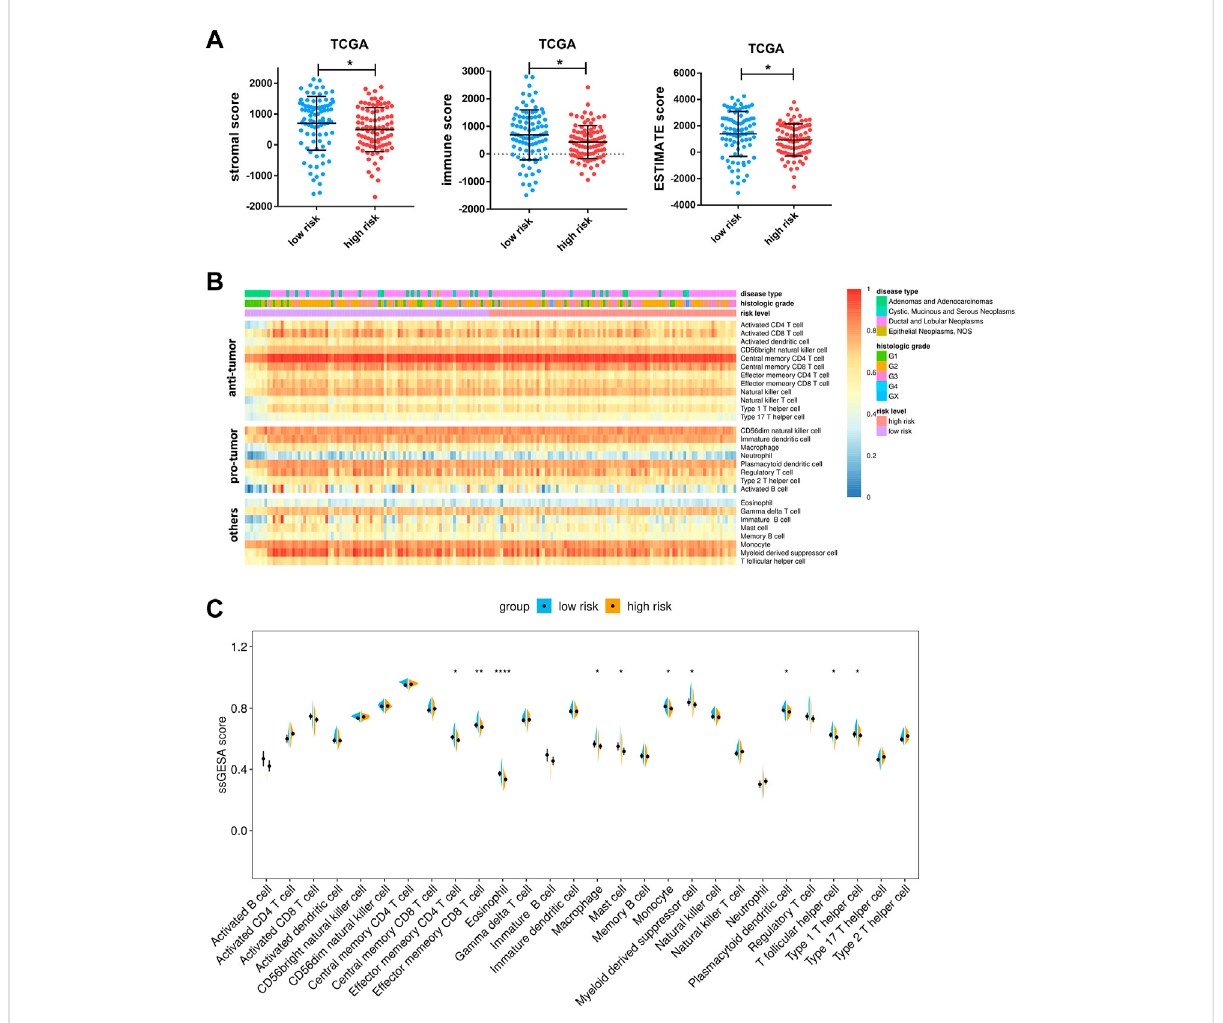
FIGURE 8 Associations between risk score and tumor microenvironment. (A) Comparison of stromal scores, immune scores, and ESTIMATE scores between the high- and low-risk groups of TCGA cohorts. (B) Heatmap of ssGSEA enrichment scores of 28 immune cell types in the TCGA cohort. Notably, the cells are grouped according to their widely accepted role in cancer, including anti-tumor, pro-tumor, and others. (C) Comparison of ssGSEA enrichment scores of 28 types of immune cells between the high- and low-risk groups in the TCGA cohort. Data are presented as means ± SD. Signi fi cant was determined using Mann-Whitney or unpaired t -test. * p < 0.05 ** p < 0.005, and **** p <